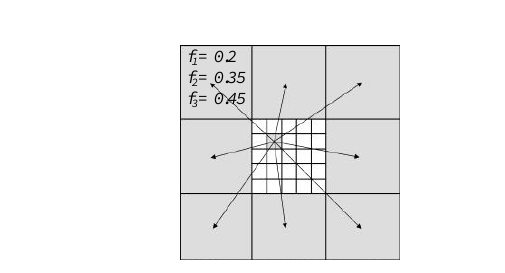
Figure 3. Determination of the attractiveness of the sub-pixel ( i ) the to the class ( j )